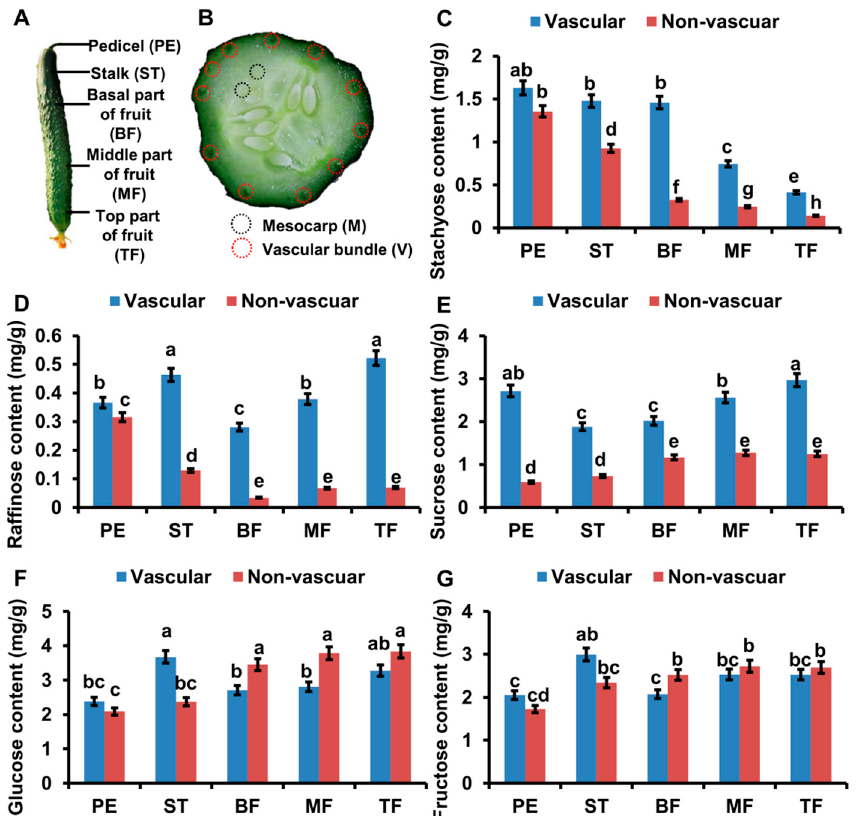
Figure 1. High accumulation of soluble sugar in vascular tissue of fruits. ( A , B ) The schematic diagram shows the sampling location in fruit. Vascular tissue and non-vascular tissue of pedicel (PE), stalk (ST), basal part (BF), middle part (MF) and top part (TF) of fruit were used for the analysis of soluble sugar content. The red circles show the vascular bundle; the white circles show the mesocarp. ( C – G ) The stachyose (Sta) ( C ), raffinose (Raf) ( D ), sucrose (Suc) ( E ), glucose (Glu) ( F ) and fructose (Fru) ( G ) content in different tissue of fruit were analysed by HPLC. The bars represent standard deviation (SD) of five biological replicates. Bars marked with different letters denote significant differences ( p < 0.05) from Student’s t